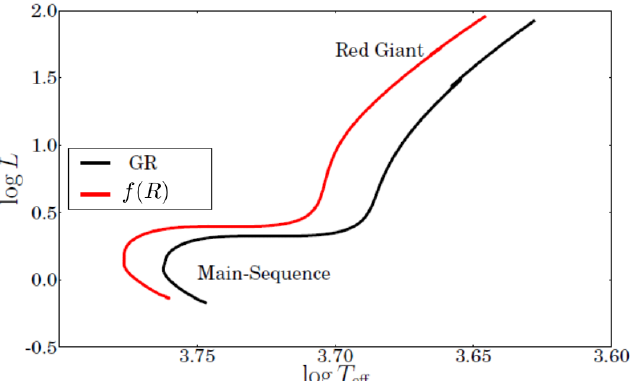
Figure 5. The colour-magnitude diagrams for a solar mass and metallicity star in GR (black) and Hu–Sawicki f ( R ) gravity with f R 0 = 10 − 6 (red). L is in units of solar luminosity and T eff is in units of